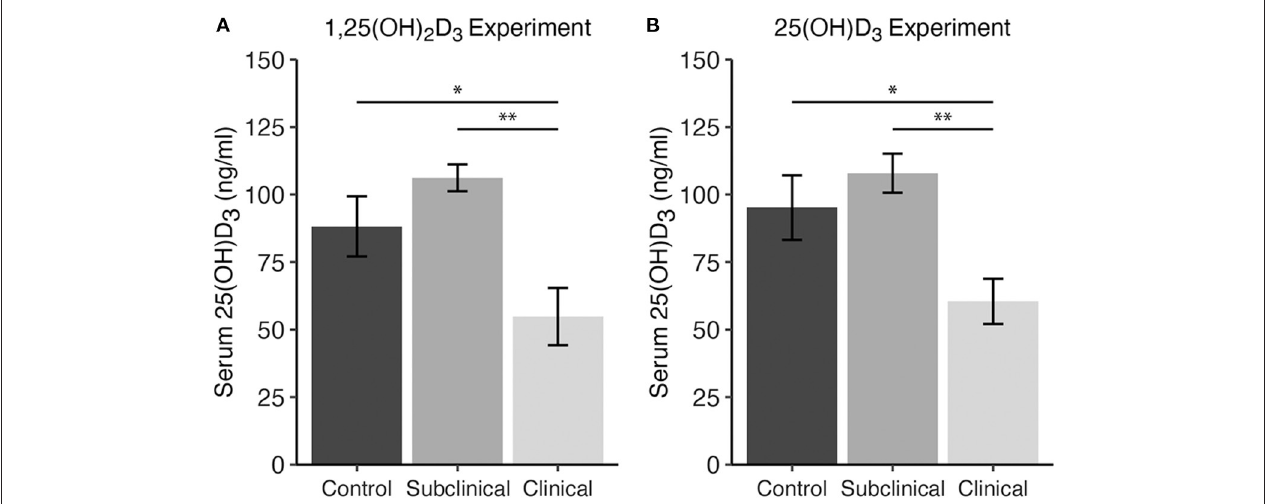
FIGURE 1 | Serum 25-hydroxyvitamin D 3 concentrations (ng/ml) for dairy cattle grouped by different stages of infection with Mycobacterium avium ssp. paratuberculosis for two separate experiments including either (A) 1,25(OH) 2 D 3 or (B) 25(OH)D 3 treatment. Each infection status group is comprised of n = 8. Whole blood was collected via jugular venipuncture into serum separation vacutainer tubes, allowed to clot, and centrifuged to collect serum. Data are presented as the mean ± SE and significance levels are as follows: * < 0.05, ** <